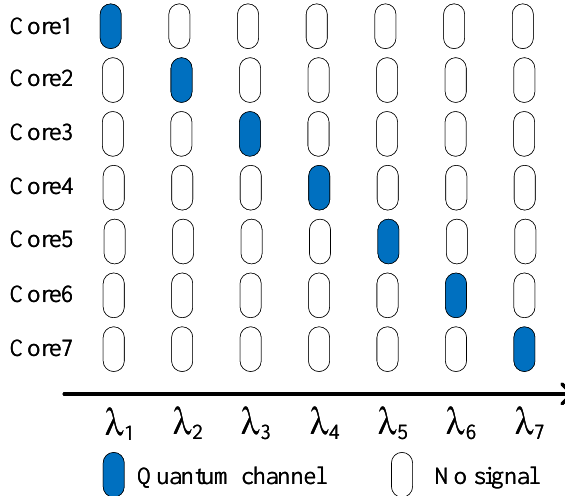
Figure 3. Different distribution of quantum channel wavelength in each